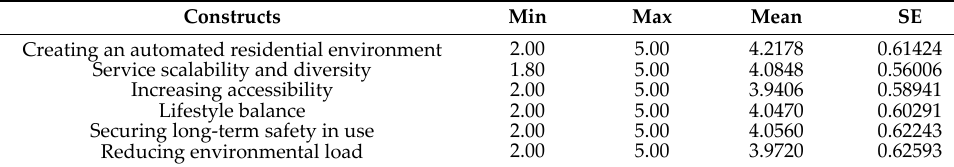
Table 5. Comparison of average importance by